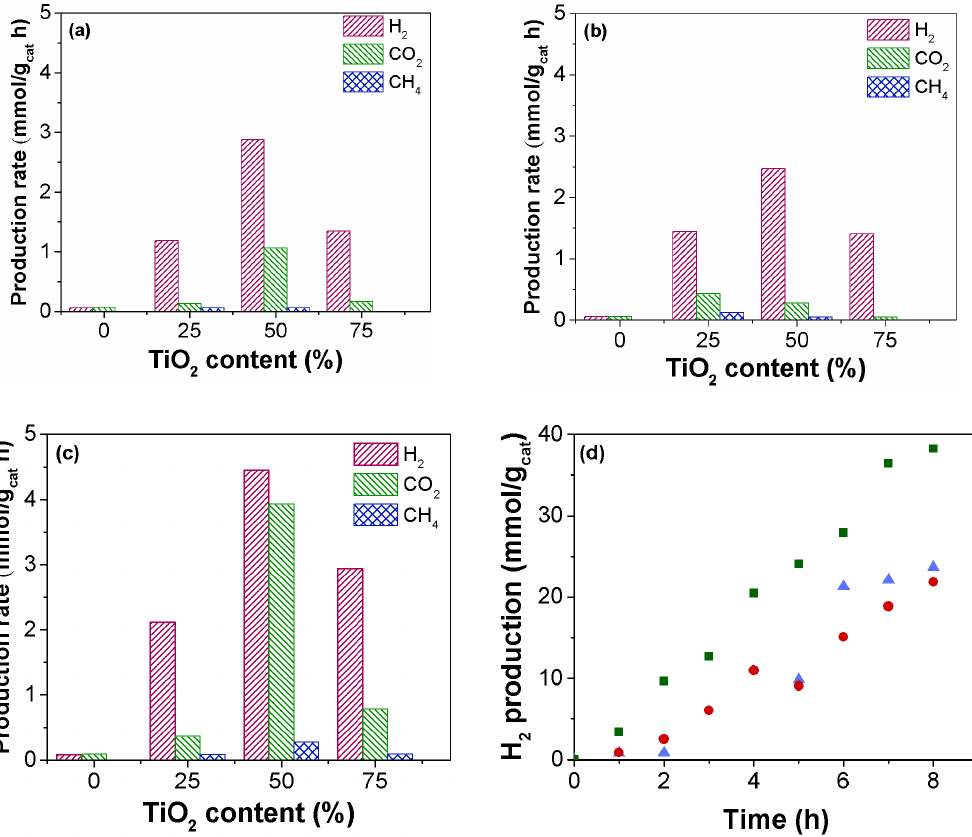
Figure 1. Effect of TiO 2 content on the H 2 , CO 2 , and CH 4 production rates of TiO 2 /HKUST-1 composites, after 8 h irradiation with simulated solar light with ( a ) TiO 2 P25/com-HKUST-1, ( b ) TiO 2 -ST/com-HKUST-1, and ( c ) TiO 2 P25/syn-HKUST-1 ( d ) Hydrogen evolution vs. time for TiO 2 /HKUST-1 composites: 50TiO 2 P25/com-HKUST-1 ( ▲ ), 50TiO 2 -ST/com-HKUST-1 (●), and 50TiO 2 P25/syn-HKUST-1 ( ).